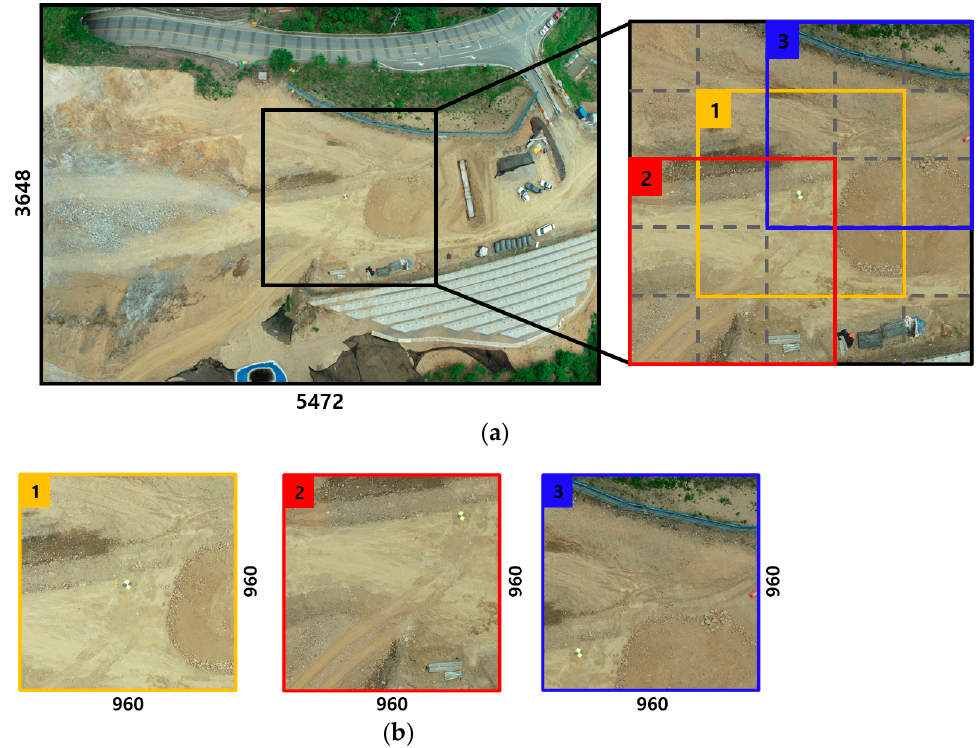
Figure 6. ( a ) Method of obtaining three tiles from one GCP in original (5372 × 3648) images for training, ( b ) Example of generated three tiles from one GCP.